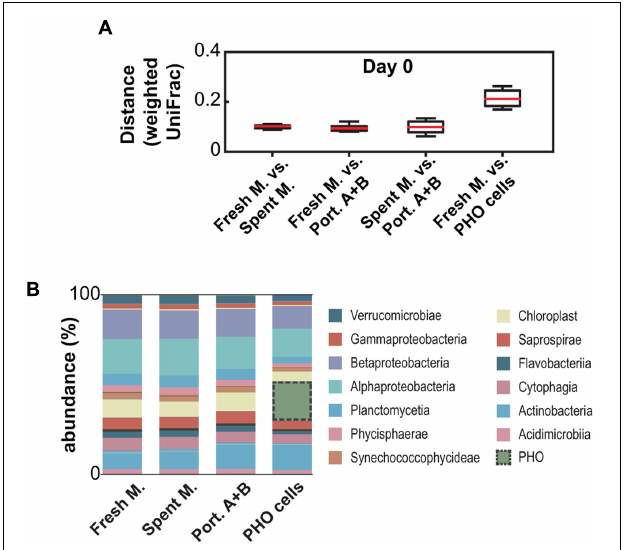
FIGURE 2 | Analysis of the initial community compositions (day 0) from 16S rDNA amplicon metagenomics data. (A) Weighted UniFrac-based pairwise distance comparison between different treatments. (B) Community composition (relative abundances, averaged) at the class/subclass level.